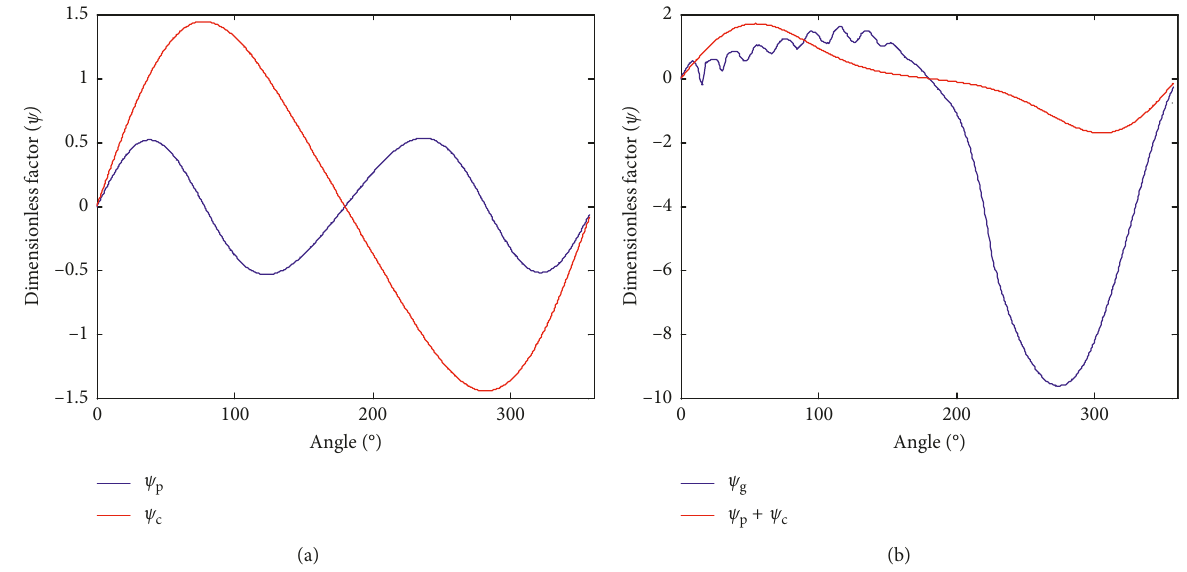
Figure 7: Inertia and gas force contributions to the piston slap without TV.